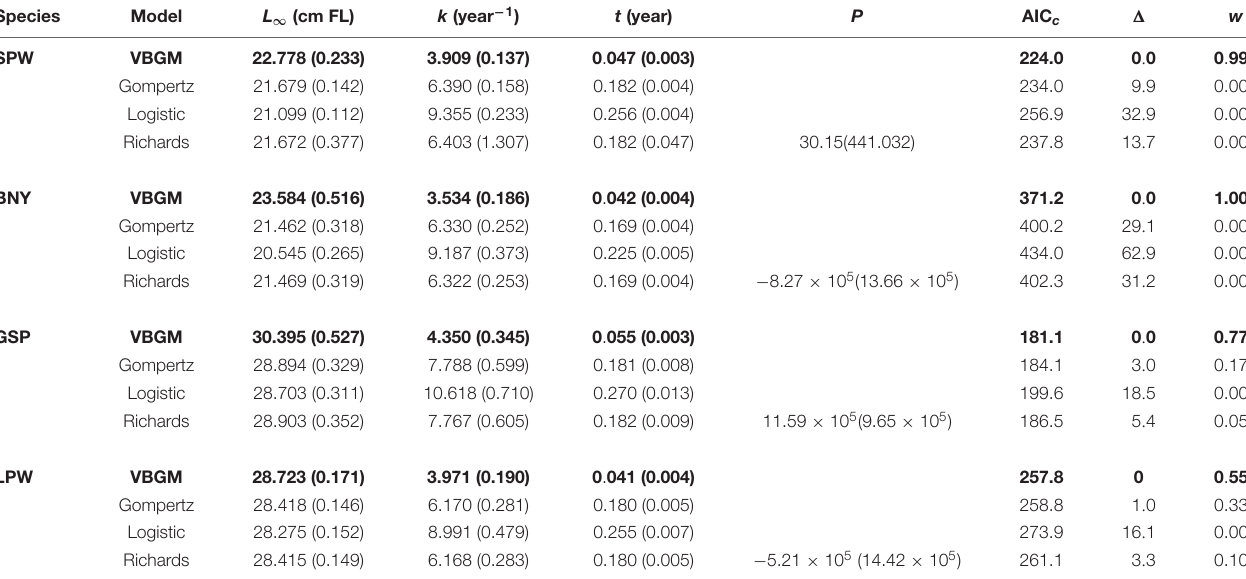
TABLE 3 | Parameter estimates ( ± standard error) from four candidate growth models for the four dominate flyingfishes off Taiwan (sex combined). Species